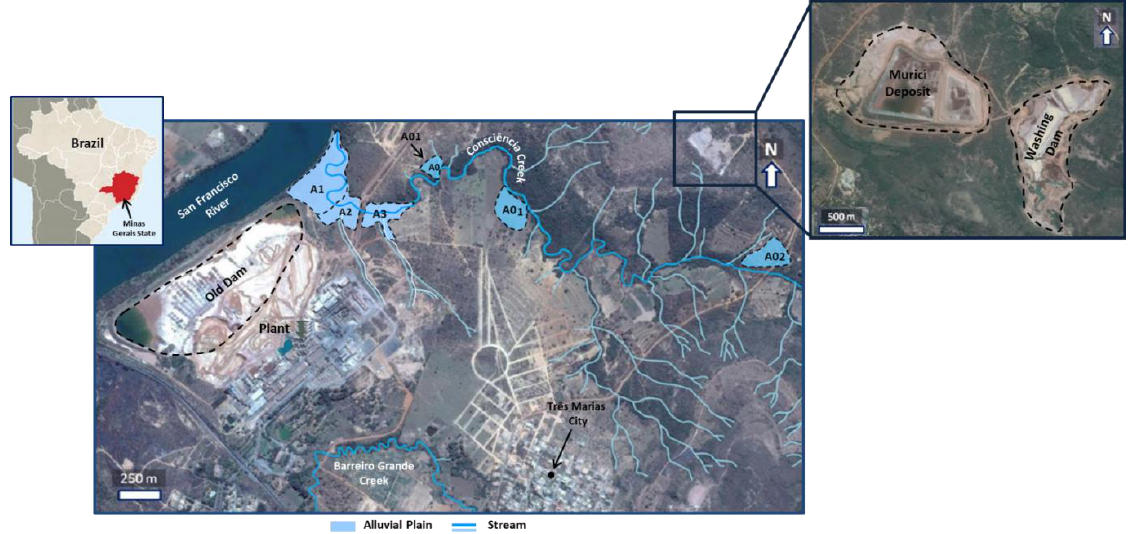
Figure 1. Study area, with location of the sampling areas (A0 to A3), the Consciência Creek and San Francisco River. Geologically the study area is included in Três Marias Formation which belongs to the Bambuí Group. The Bambuí Group, the largest group in the San Francisco Craton, represents the most characteristic unit of the basin and it includes fractions of altered carbonate rocks, spread over different formations including the Tr ê s Marias formation [12]. This formation is at the top of the Bambu í Group consisting of a thick sedimentary sequence represented by layers of sandstone of fine to very fine grain size, interlayered with arcosic siltstones rich in quartz, feldspar and heavy/dense minerals of iron oxides, tourmaline, zircon, epidote, and garnet, with an approximate age of 600–650 Ma [12–14], Figure 2.